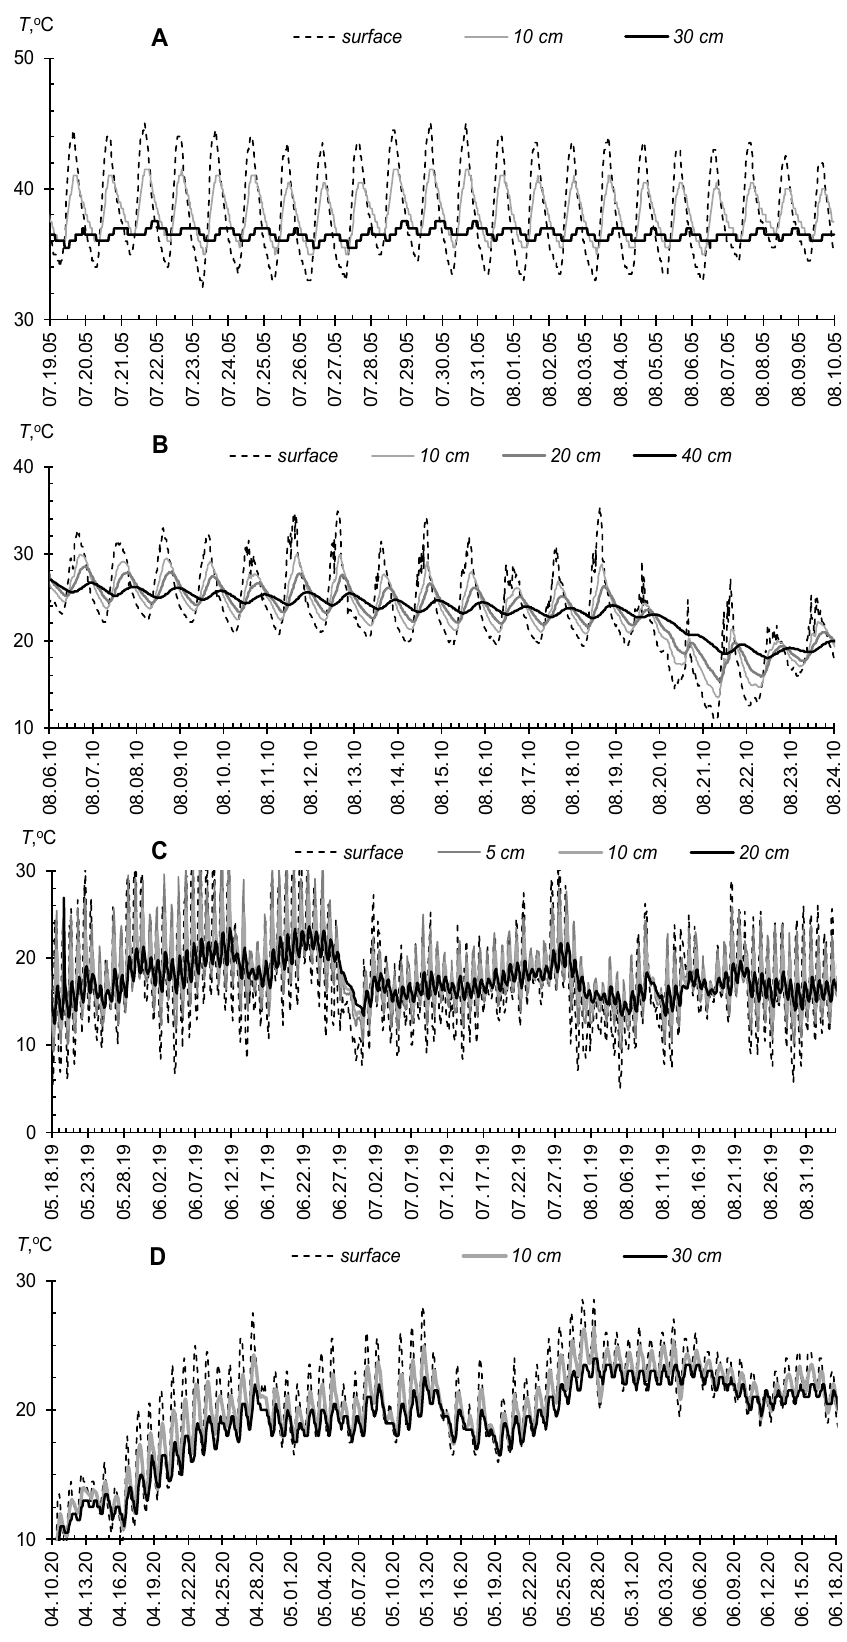
Figure 4. Fragments of soil temperature monitoring (DS1923 loggers): ( A )—Qatar (2005); ( B , C )—Moscow region (2010, 2019); ( D )—Uzbekistan (2020).